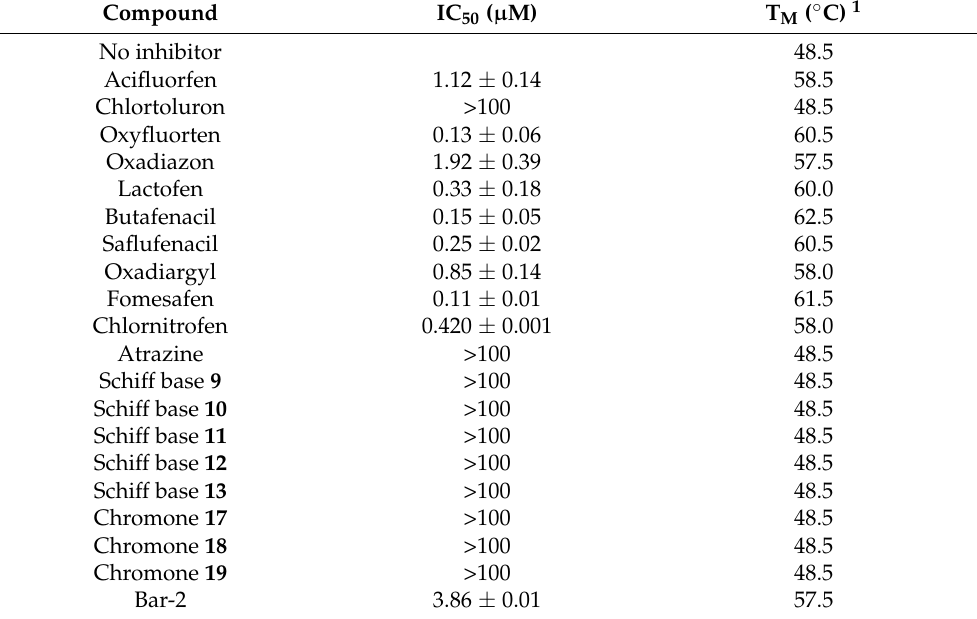
Table 1. IC 50 values against hPPO for the tested inhibitors and meting temperatures for the hPPO inhibitor